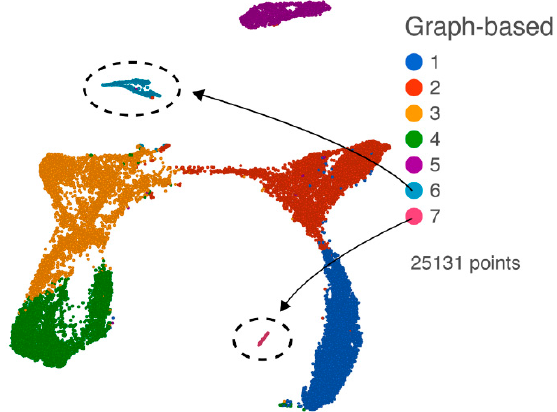
Figure 2. UMAP plot of all cells following QA/QC, normalization, and filtering with the annotated gene list. Graph-based clusters are designated by different colors, and cluster 6 (CTL and NK cells) and cluster 7 (endothelial cells) are indicated.